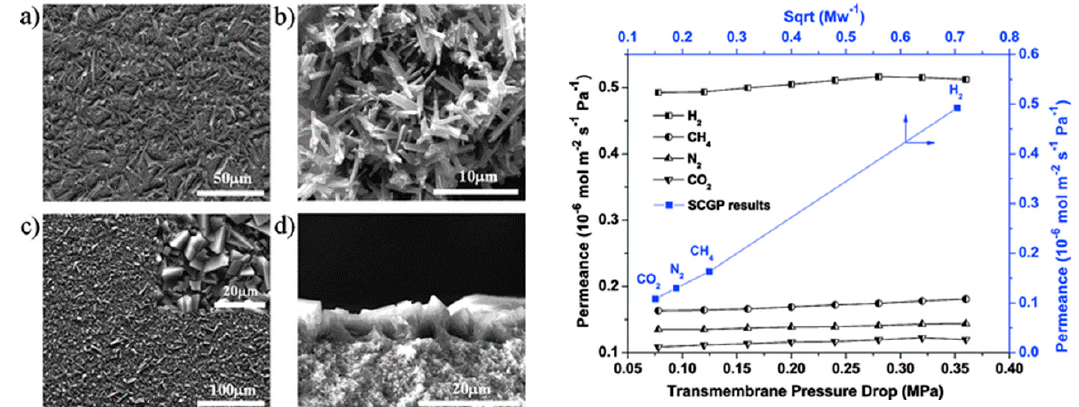
Figure 27. ( Left ). SEM images of the MIL-53 seed layer ( a ), MIL-53 powders ( b ), MIL-53 membrane surface ( c ), and cross-section ( d ). ( right ) Permeances of small gas molecules through an MIL-53 membrane at different trans-membrane pressure drops, and the single-component gas permeation (SCGP) results through the MIL-53 membrane under 0.8 MPa (adapted with permission from ref. [91]).